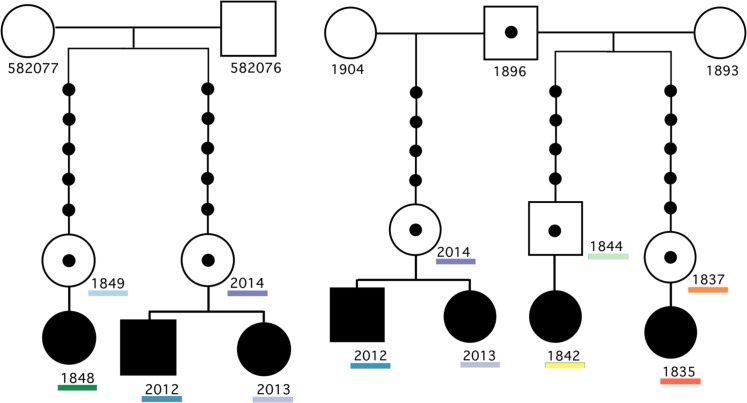
Identification of Shared Genomic Segments in TAPVR pedigrees.Two pedigrees with TAPVR affected patients which shared genomic segments greater than 5cM. The colors below the patient ID correspond with the IBD segments shown in Fig 2. Note, the affected siblings 2012 and 2013 are related to other TAPVR affected individuals through two separate lineages (both through their mother) as depicted by two pedigrees.